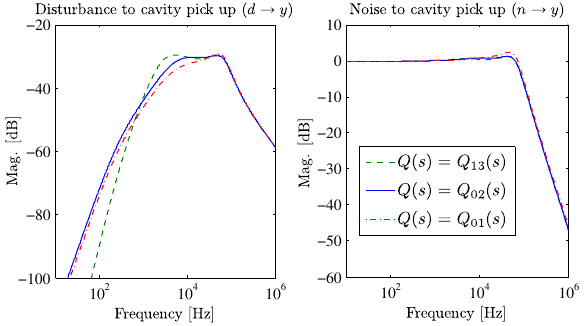
FIG. 12. Transfer functions from d and n to y via different Q filters in the PI þ DOB control (assuming δω ¼ 0 and δθ ¼ 0 ).